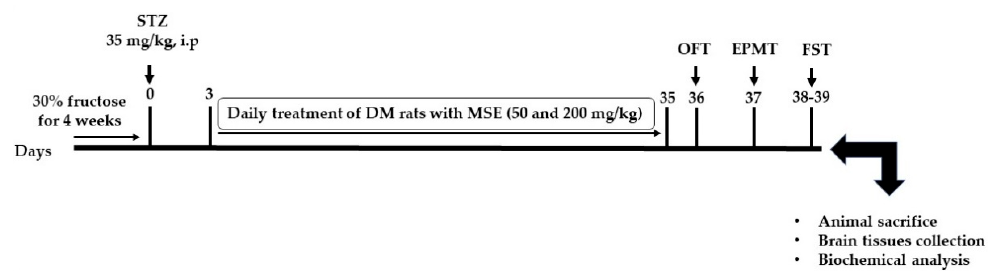
Figure 6. Experimental schematic